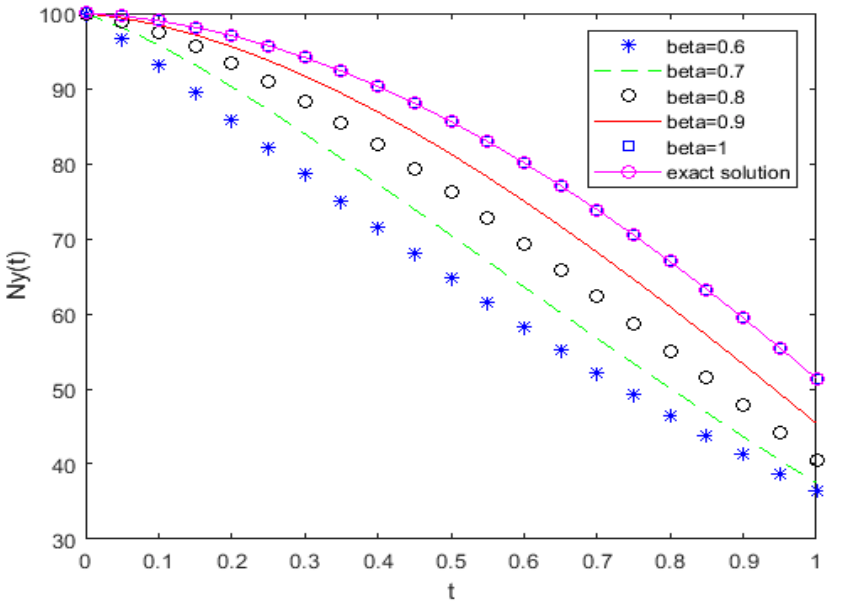
Figure 21. Behaviour of the approximate solution of N y ( t ) at β = 0.6, 0.7 ,0.8, 0.9 and 1, with parameters: w 0 = 1, T 1 = 1, T 2 = 20, a = 1, b = 1.